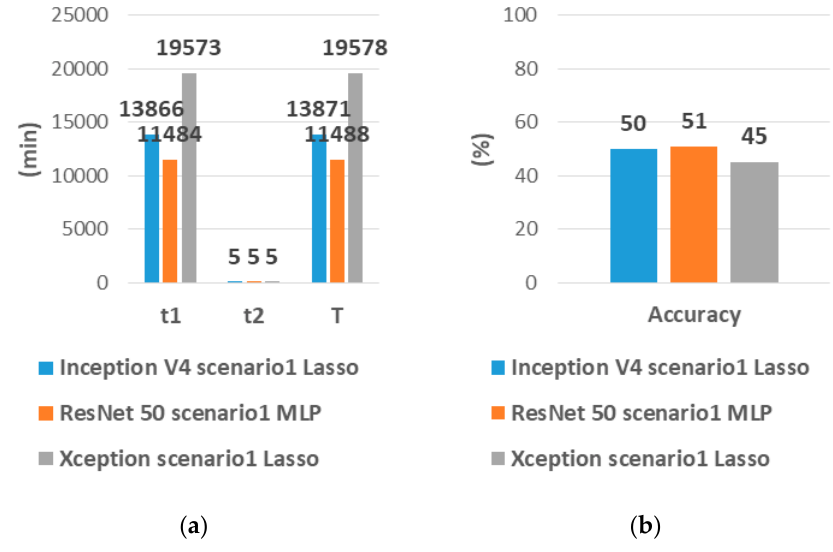
Figure 4. ( a ) Training data collection time t 1 , training time t 2 , and total time T of scenario 1, ( b ) For each CNN model, the highest processing prediction accuracy of scenario 1.